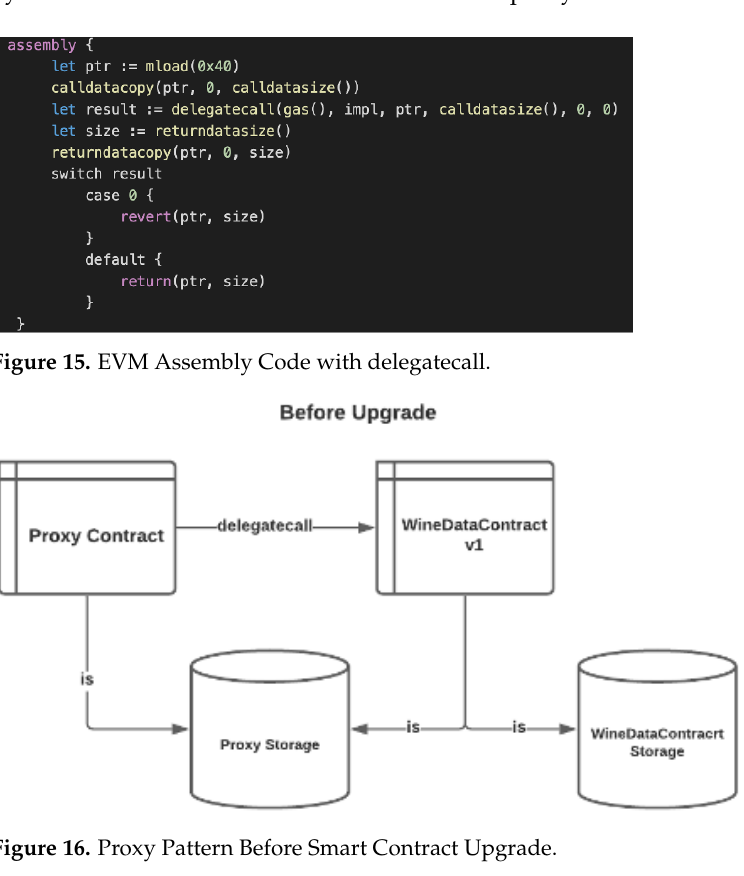
Figure 16. Proxy Pattern Before Smart Contract Upgrade.